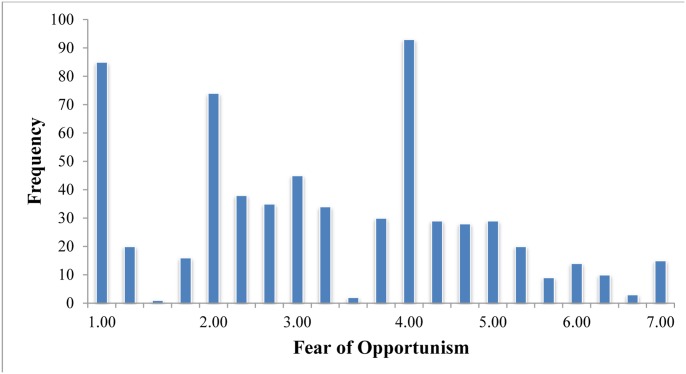
Histogram of responses to fear of opportunism scale.